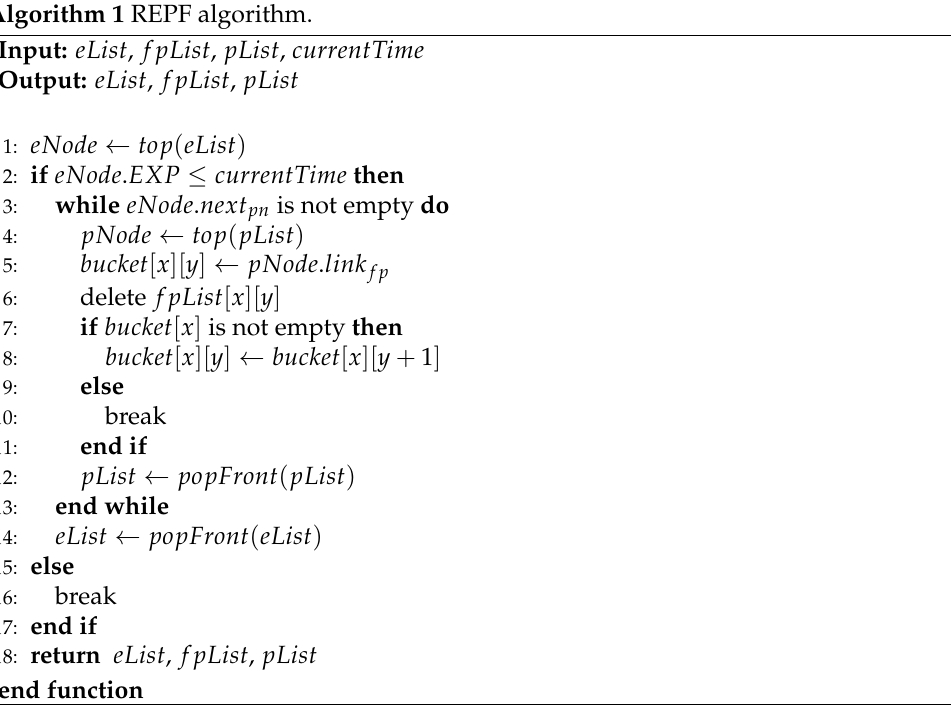
Figure 7. Remove the expired pseudonym and fingerprint algorithm. Algorithm 1 REPF